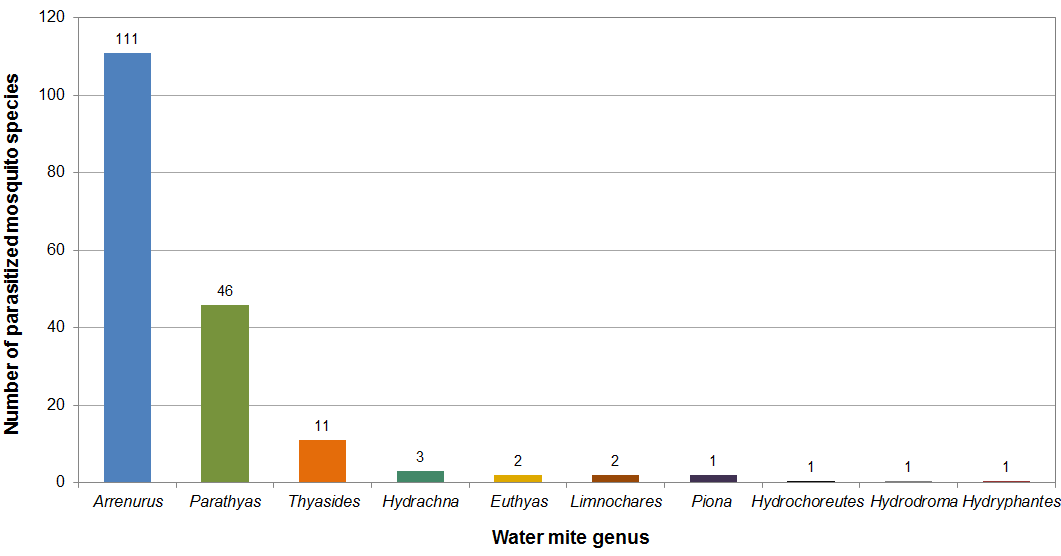
Figure 4. Number of parasitized mosquito species that are parasitized by each water mite genus, as reviewed by Atwa, Bilgrami, and Al-Saggaf [36]; Leal dos Santos [43]; Manges, Simmons, and Hutchinson [37]; and Simmons and Hutchinson [34].